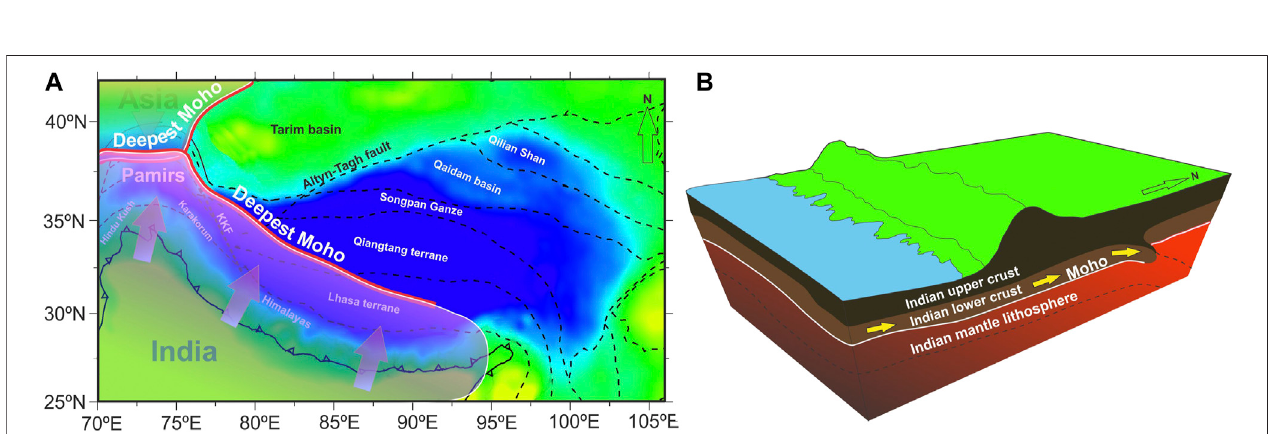
FIGURE 4 | (A) Sketch map showing the deepest Moho interface beneath the Pamir – Tibetan plateau. The bold red lines show the deepest Moho depth with a northward direction interface along the N-S pro fi les across the Tibetan plateau and a southward direction interface beneath the Pamir plateau. The black dashed lines mark the main tectonic boundaries. (B) Cartoon showing the crust and Moho topography, with north dip interface of the Moho discontinuity at the northern margin of Indian lower crust with the deepest Moho forming a synform and step-rise form.